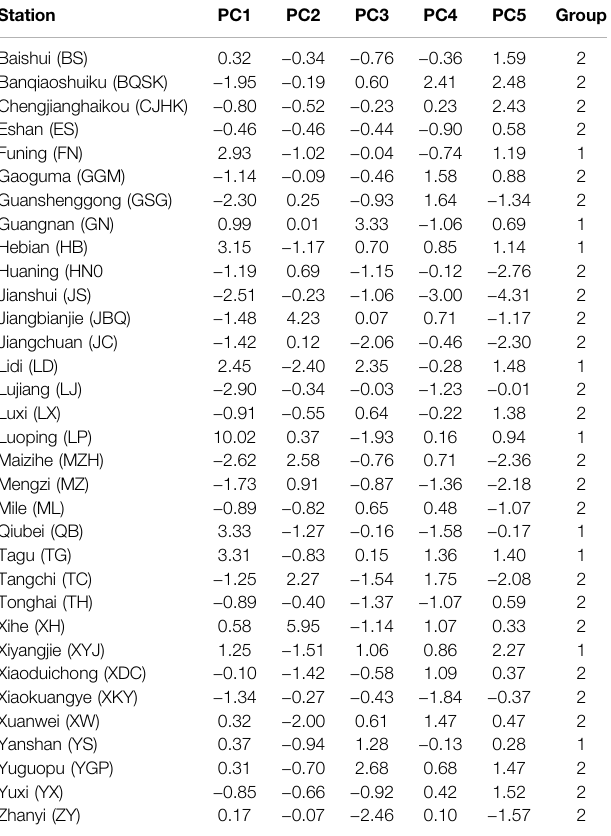
TABLE 4 | Principal component score of rainfall station.